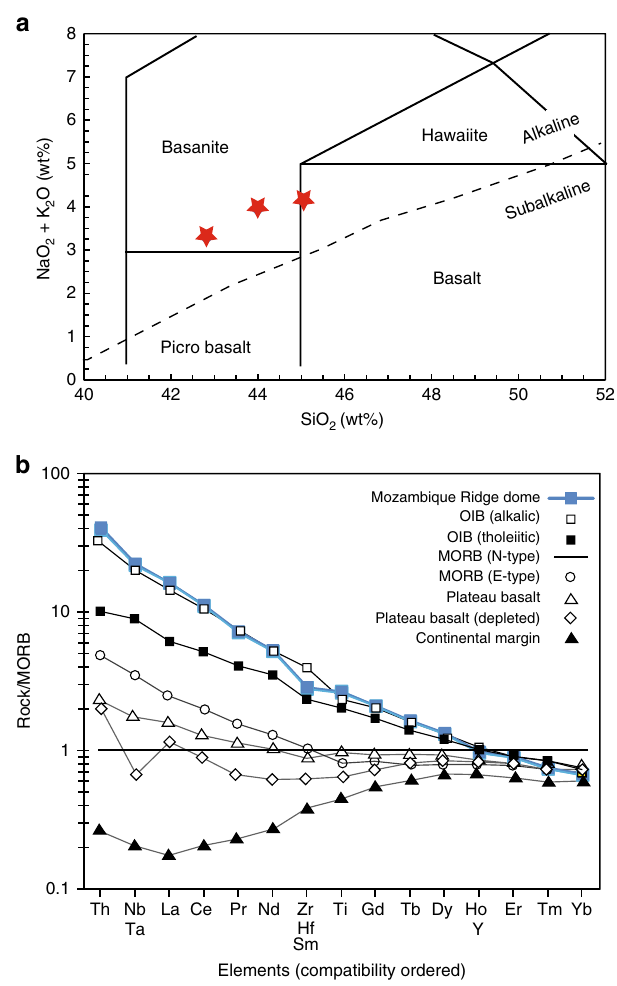
Fig. 3 Major and trace element classi fi cation. a Total alkali vs. silica diagram. Based on silica and total alkali contents and the classi fi cation diagram of ref. 99 MW14DL2-2 and MW14DL2-3 are basanites and MW14DL3-5 is a transitional between a basanite and an alkali basalt. b MORB-normalized trace element concentration patterns of dome samples compared with the compositional range of oceanic basalt types in the present-day ocean basins from ref. 100 (see also for details of the following data sources). N-MORB (also the normalizing factor) and E- MORB data are from the compilation in Sun and McDonough 101 ; intraplate islands (islands on ridge-distal oceanic lithosphere) are represented by alkalic OIB (the OIB average of Sun and McDonough) 101 and a tholeiitic basalt standard from Hawaii (BHVO1); the plateau basalt data are from the Ontong-Java Plateau in Mahoney et al. 102 ; the depleted plateau basalt data is from Gorgona Island in Révillon et al. 103 . Note that the data for the three dome samples are very similar and so plot on top of each